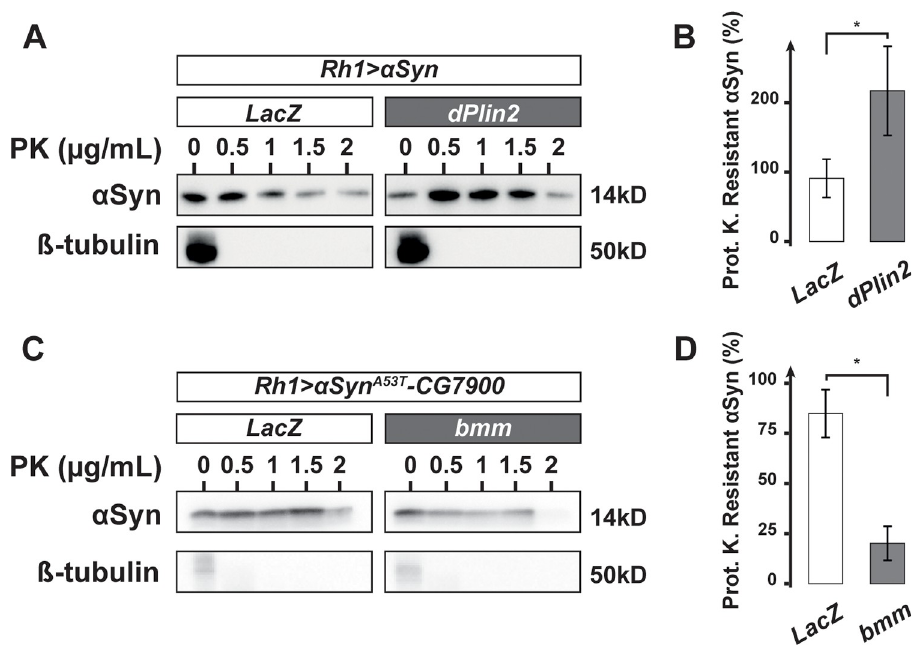
Fig 6. LDs promote α Syn resistance to proteinase K in Drosophila photoreceptors. (A) α Syn proteinase K- resistance assay. Lysates of the heads of 30-day-old flies with photoreceptor neuron-specific expression of α Syn WT and either LacZ (control) or dPlin2::GFP were digested with the indicated concentrations of proteinase K and then immunoblotted for α Syn or β -tubulin (loading control). (B) Quantification of proteinase K-resistant α Syn, as analyzed in (A). Resistance is expressed as the ratio of α Syn detected after treatment with 1 μ g/mL of proteinase K relative to the untreated sample. Mean ± SD. � p < 0.05 by student test. (C) α Syn proteinase K-resistance assay. Lysates of the heads of 30-day-old flies with photoreceptor neuron-specific expression ( Rh1-GAL4 ) of α Syn A53T -CG7900 and either LacZ (control) or bmm lipase were digested with the indicated concentrations of proteinase K and then immunoblotted for α Syn or β -tubulin (loading control). (D) Quantification of proteinase K-resistant α Syn, as analyzed in (B). Resistance is expressed as the ratio of α Syn detected after treatment with 2 μ g/mL of proteinase K relative to the untreated sample.